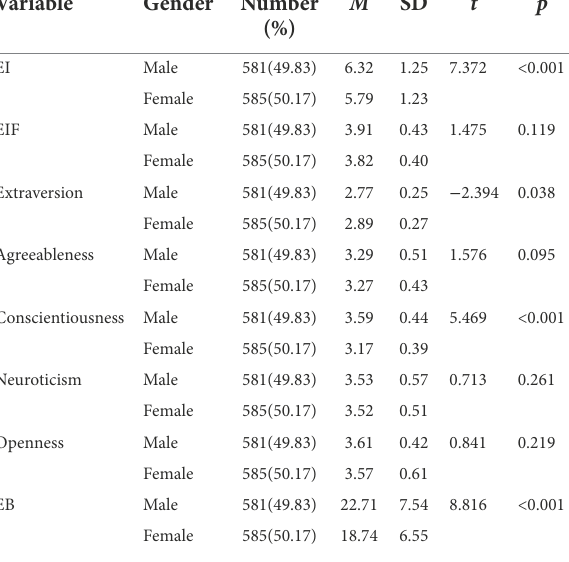
TABLE 1 Differences in